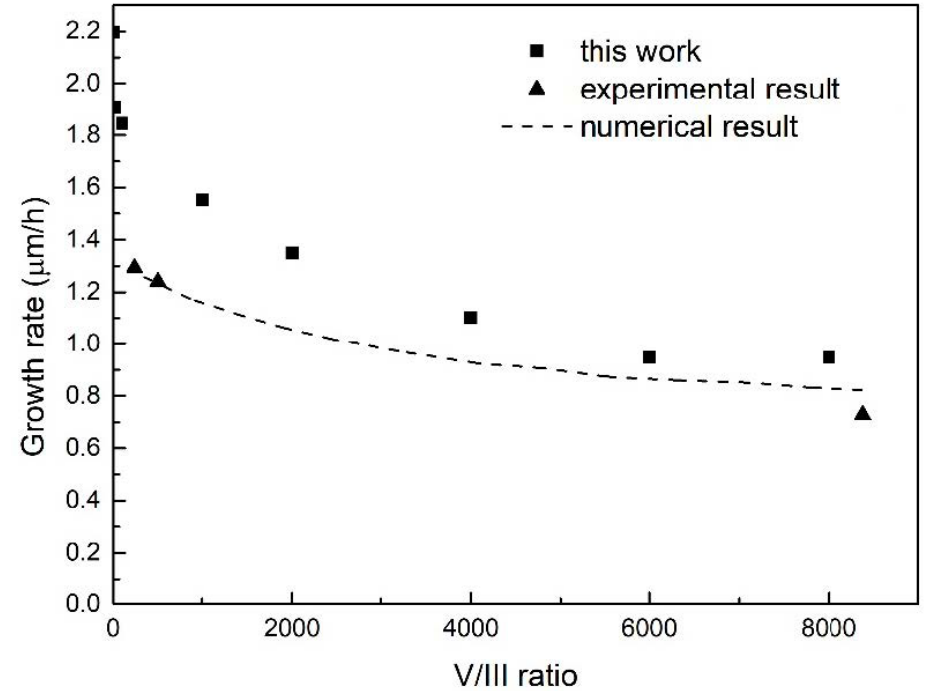
Figure 2. Relationship between the average growth rate and the V/III along the entire wafer surface. The square points represent the results obtained in this work and the dashed line and triangles indicate the results from a previous numerical and experimental study [14].